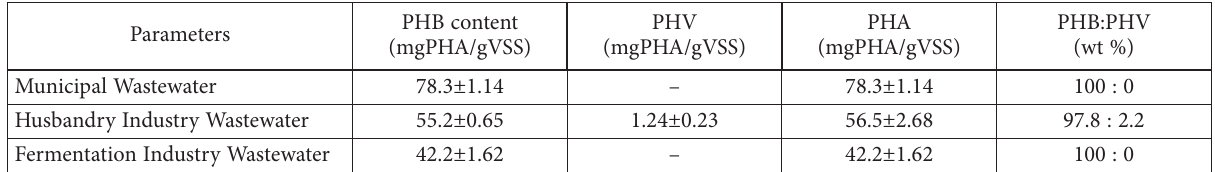
Table 2. Initial PHA content of the sludge